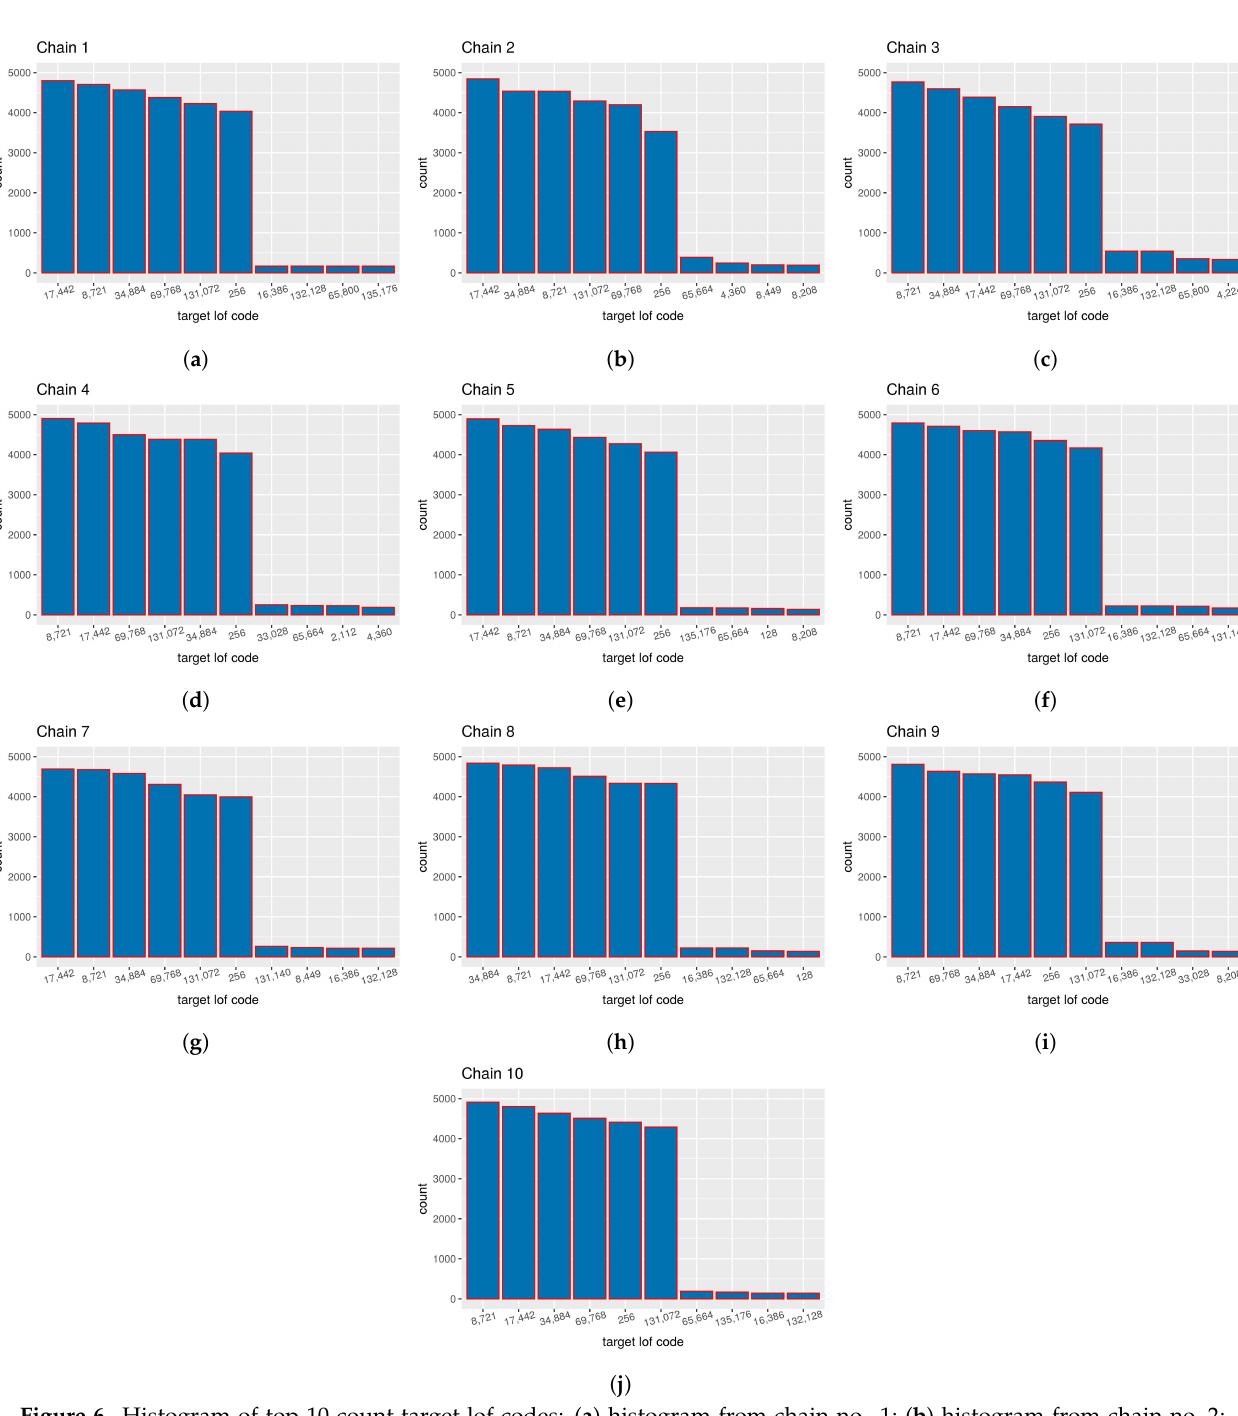
Figure 6. Histogram of top 10 count target lof codes: ( a ) histogram from chain no. 1; ( b ) histogram from chain no. 2; ( c ) histogram from chain no. 3; ( d ) histogram from chain no. 4; ( e ) histogram from chain no. 5; ( f ) histogram from chain no. 6; ( g ) histogram from chain no. 7; ( h ) histogram from chain no. 8; ( i ) histogram from chain no. 9; and ( j ) histogram from chain no.